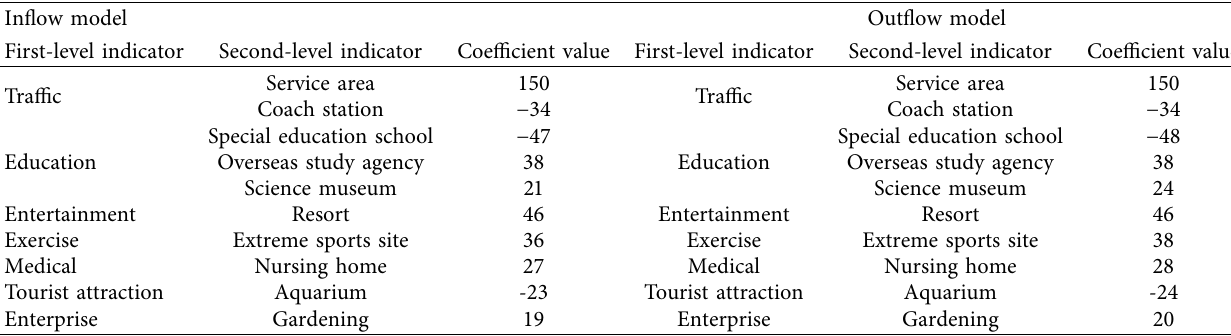
Table 10: Top 10 variables with the largest absolute value of coefficient in model.